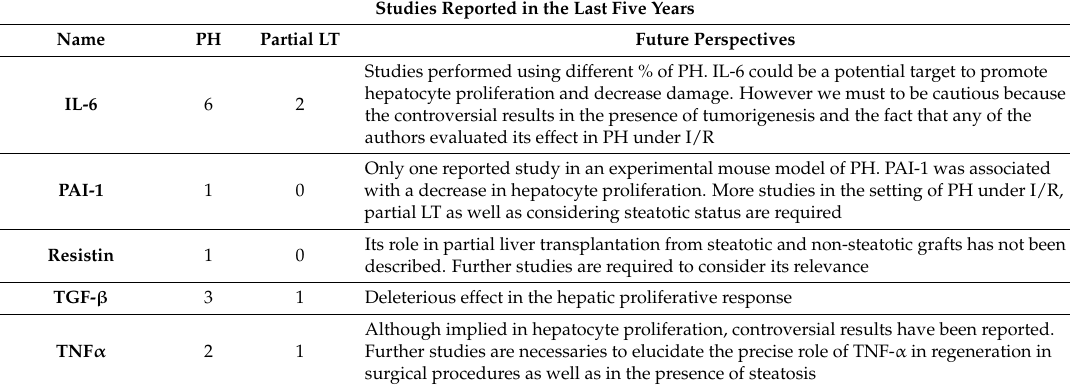
Table 3. Future perspectives in the use of adipokines implied in regeneration and/or liver diseases as therapeutic target to alleviate I/R injury and improve liver regeneration in the surgery of hepatic resections and partial liver